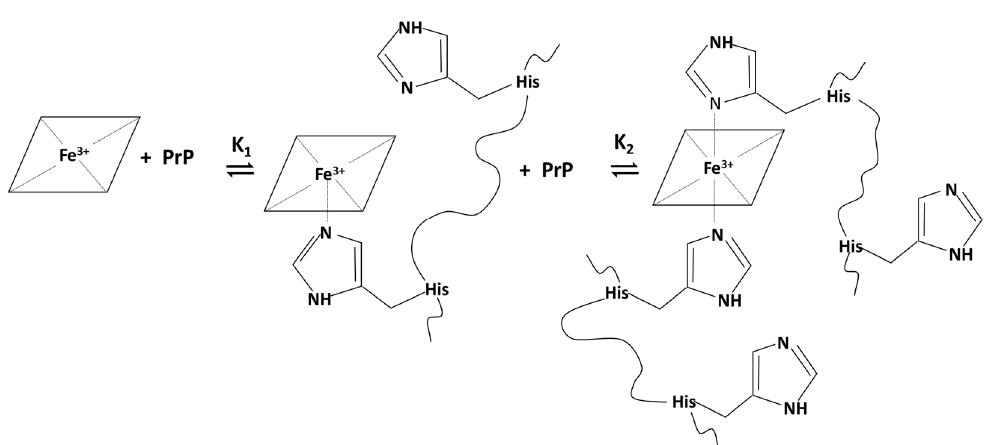
Figure 5. Schematic representation of the formation of 1:1 high-spin five-coordinated and 1:2 low-spin six-coordinated complexes through two distinct subsequent equilibria, ruled by K 1 and K 2 affinity constants, respectively.